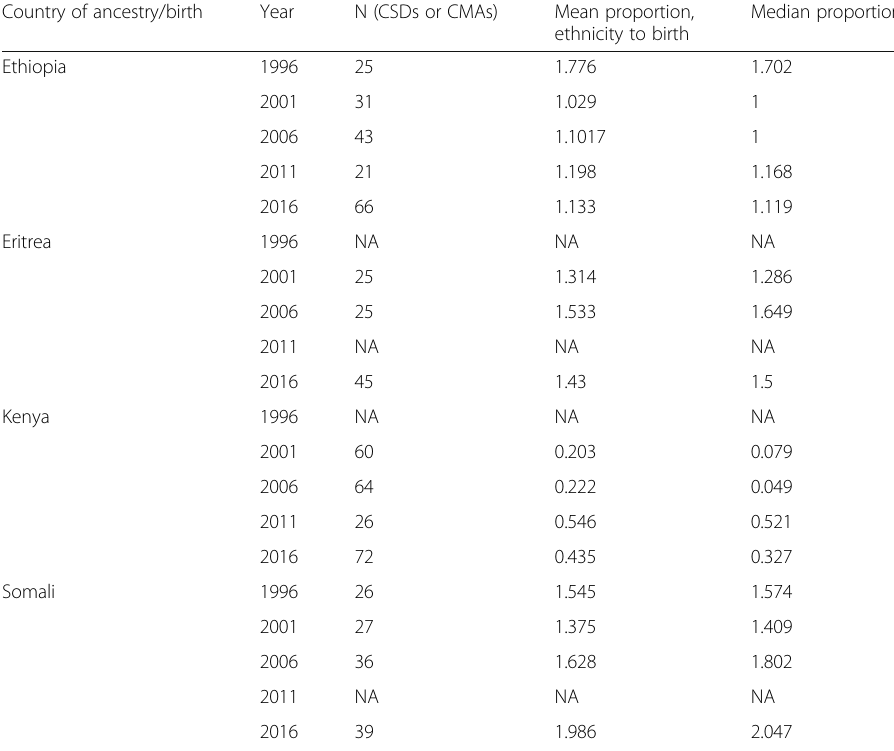
Fig. 6 Ethiopian (top), Amhara (center) and Oromo (bottom) populations in Canada, 2016